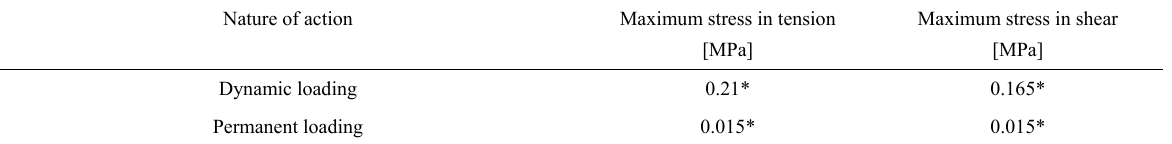
Table 2: Allowable stresses of the structural sealant